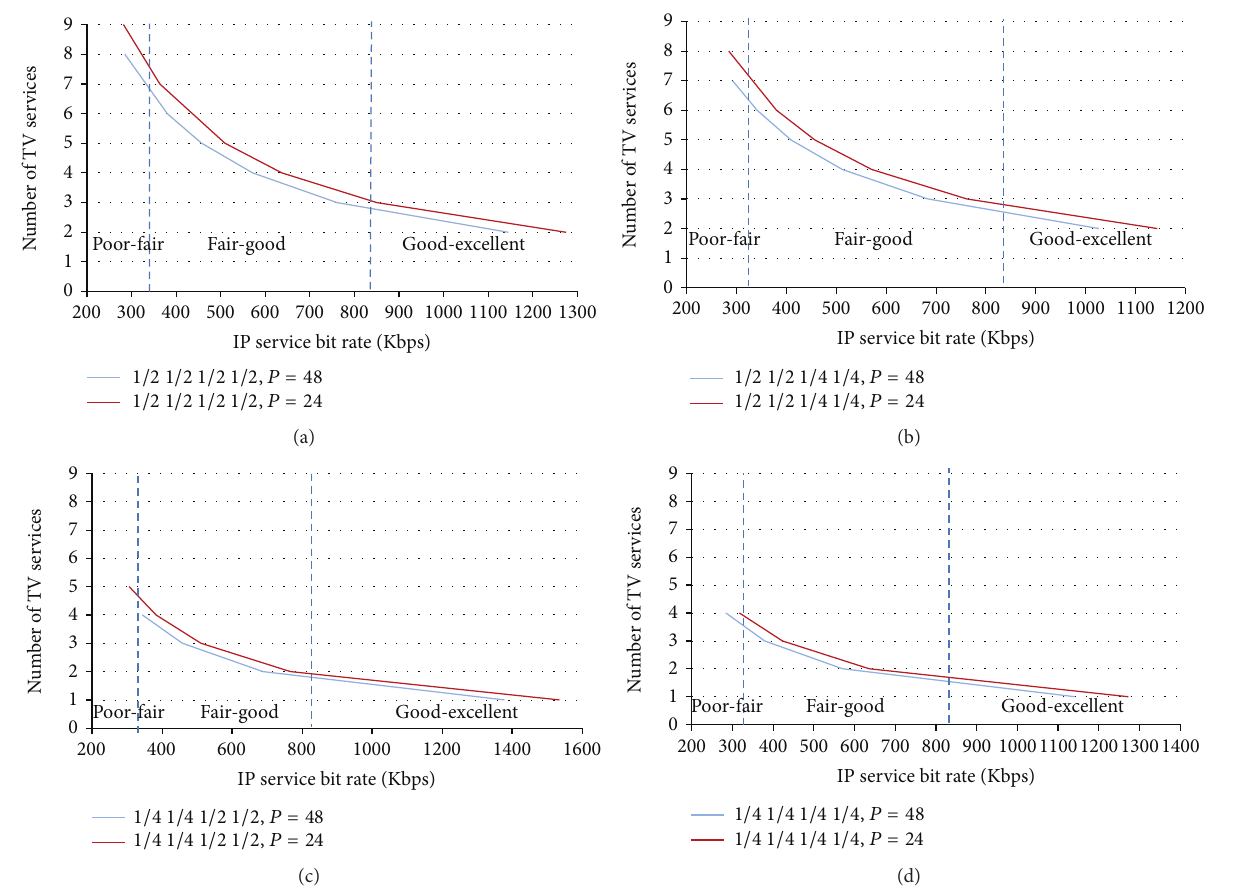
Figure 3: The maximum number of mobile TV services per parade in function of service bit rate in different ranges of video quality for different robustness